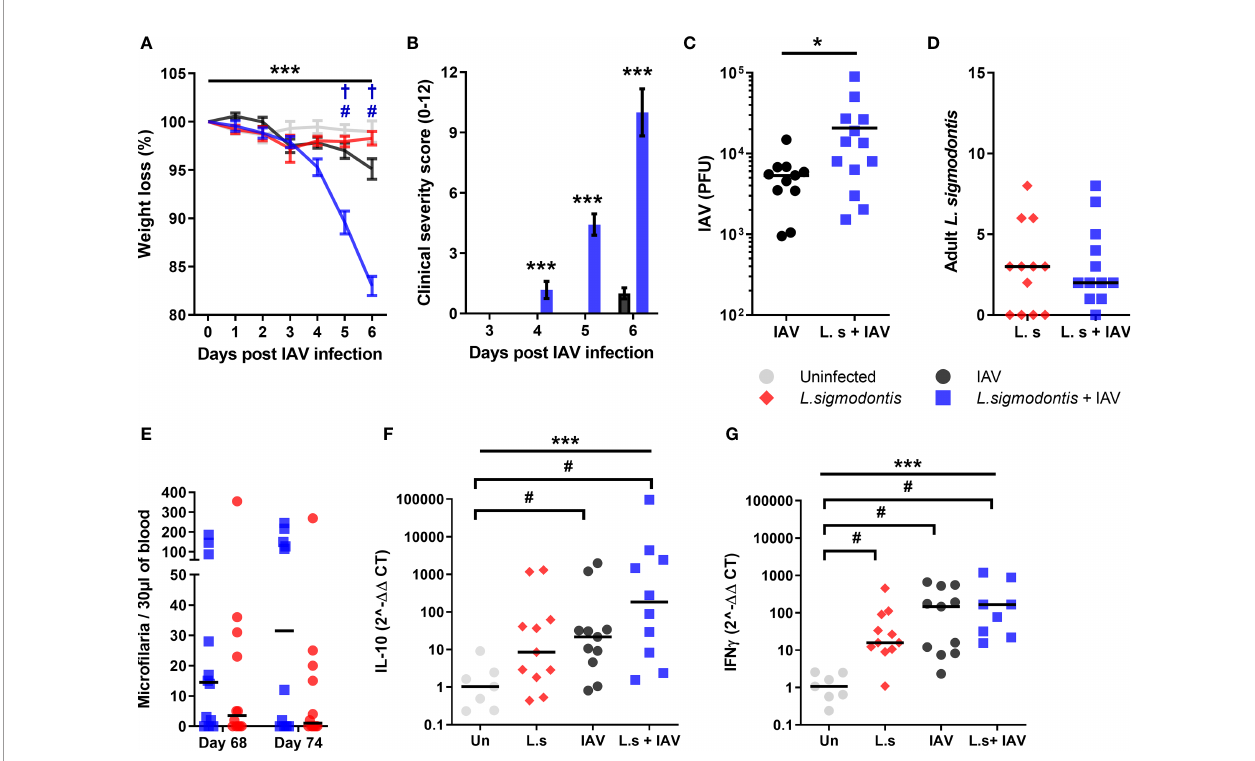
FIGURE 3 | Co-infection during patent L. sigmodontis infection increases susceptibility to IAV, and blocks age-related resistance to IAV clinical signs. All panels show combined data from two independent experiments. Uninfected n=12, IAV n=11, L. sigmodontis n=12, IAV + L. sigmodontis n=13 (A) Weight loss over time (d post IAV infection) shown as mean ± SEM, ***signi fi cant effect between groups over time, p < 0.001 (GLM). # p < 0.05 signi fi cant effect between IAV infected and coinfected group (Tukey ’ s HSD). † p < 0.05 signi fi cant effect between uninfected and coinfected group (Tukey ’ s HSD). (B) Combined clinical severity score. Median ± MAD shown. ***p < 0.001 (Mann Whitney U test) (C) IAV titre (PFU) in lung homogenates 6 d post IAV infection. Mean ± SEM. *p < 0.05 (unpaired T test). (D) Numbers of adult L. sigmodontis recovered 6 d post IAV infection. Median and individual mice shown ( L.sigmodontis n=12, IAV + L. sigmodontis n=13). (E) Mf count in 30 m l blood before and after IAV co-infection. Median and individual mice shown. (F, G) Expression of IL-10 (F) and IFN- g (G) mRNA in the lung. ***Signi fi cant effect between groups, p < 0.001 (ANOVA), # p < 0.05 (Tukey ’ s